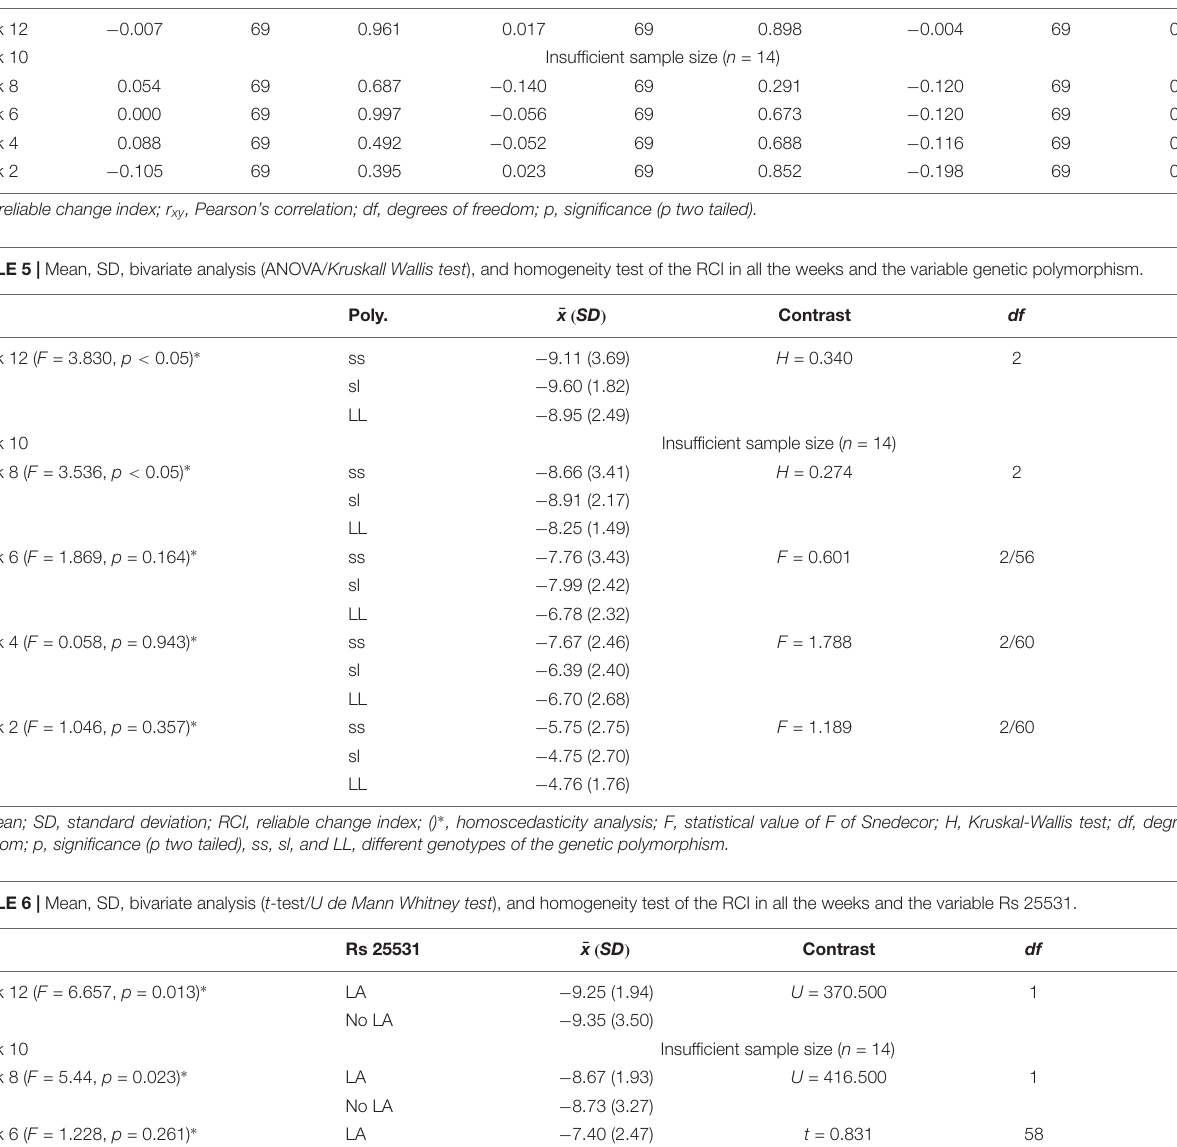
TABLE 4 | Pearson correlation, degrees of freedom, p -value and effect size of the bivariate analysis between the RCI in weeks 12, 10, 8, 4, and 2 and the quantitative variables of the subject. RCI Age Years of formal education Premorbid intelligence r xy Week 12